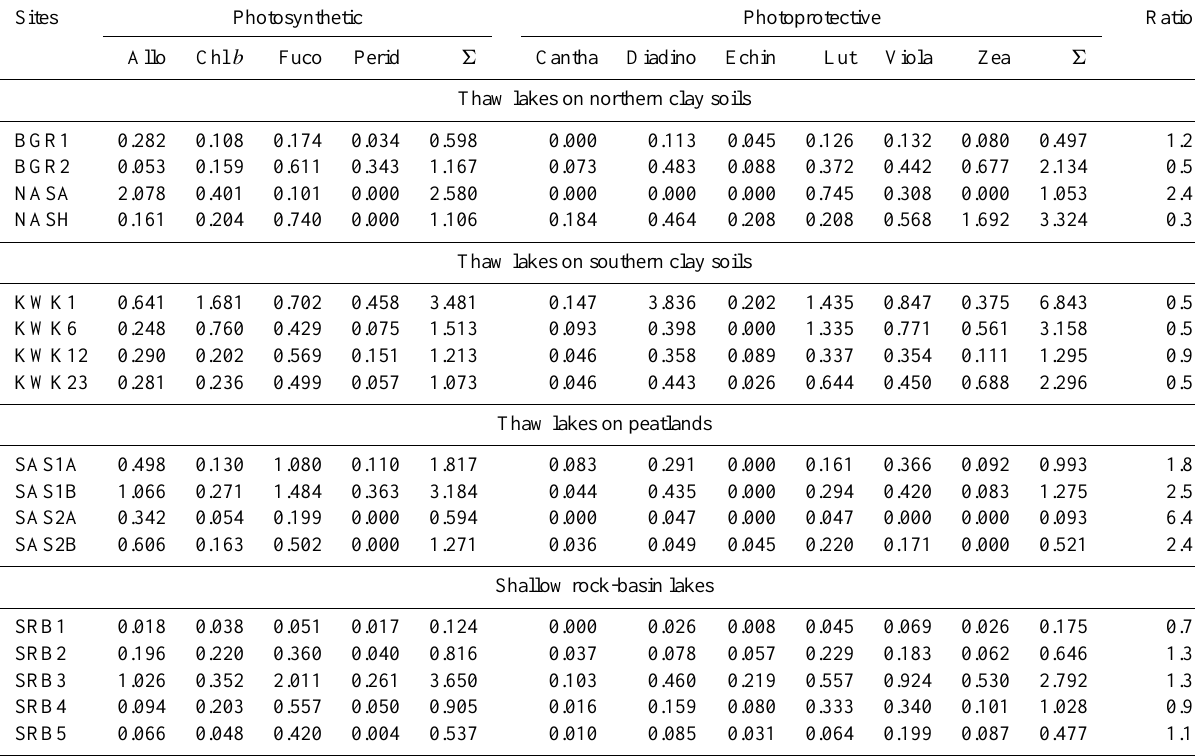
Table 2. The dominant photosynthetic and photoprotective accessory pigments (nmolL − 1 ), their sums ( (cid:54) ) and ratio in each of the subarctic water bodies sampled in 2012.